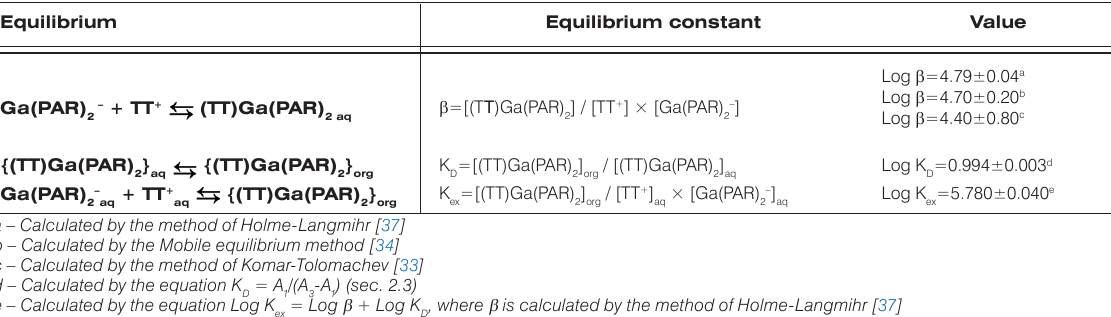
Table 3. Extraction equilibria and conditional equilibrium constants for the Ga(III)-PAR-TTC-water-chloroform system.